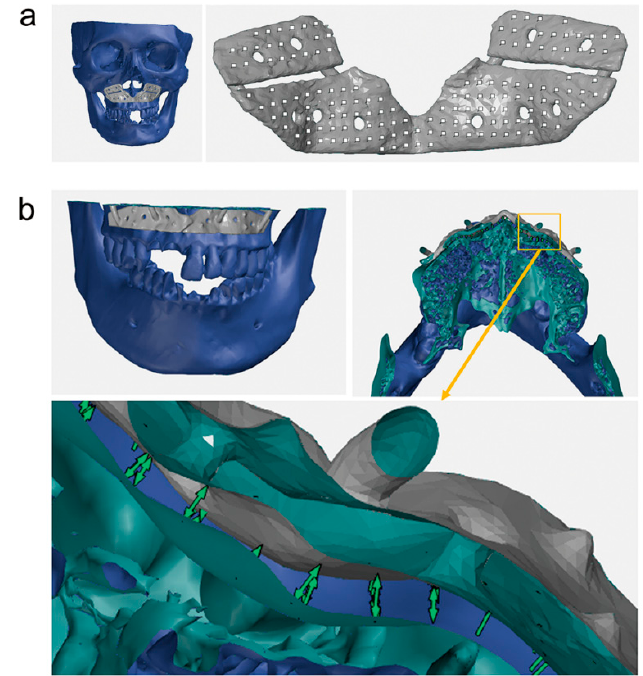
Figure 3. Fitness of the CAD / CAM-based surgical templates. ( a ) Evaluation of the fitness of the surgical template. The image on the right shows the import of the template and the skull model. The image on the left shows the creation of the evenly distributed surface points on the inner surface of the template. All points were created automatically by the software, and the distance between each point was set to 2.0 mm. ( b ) Measurement of the distance between the point on the inner surface of the template and its projected point on the underlying bone surface.